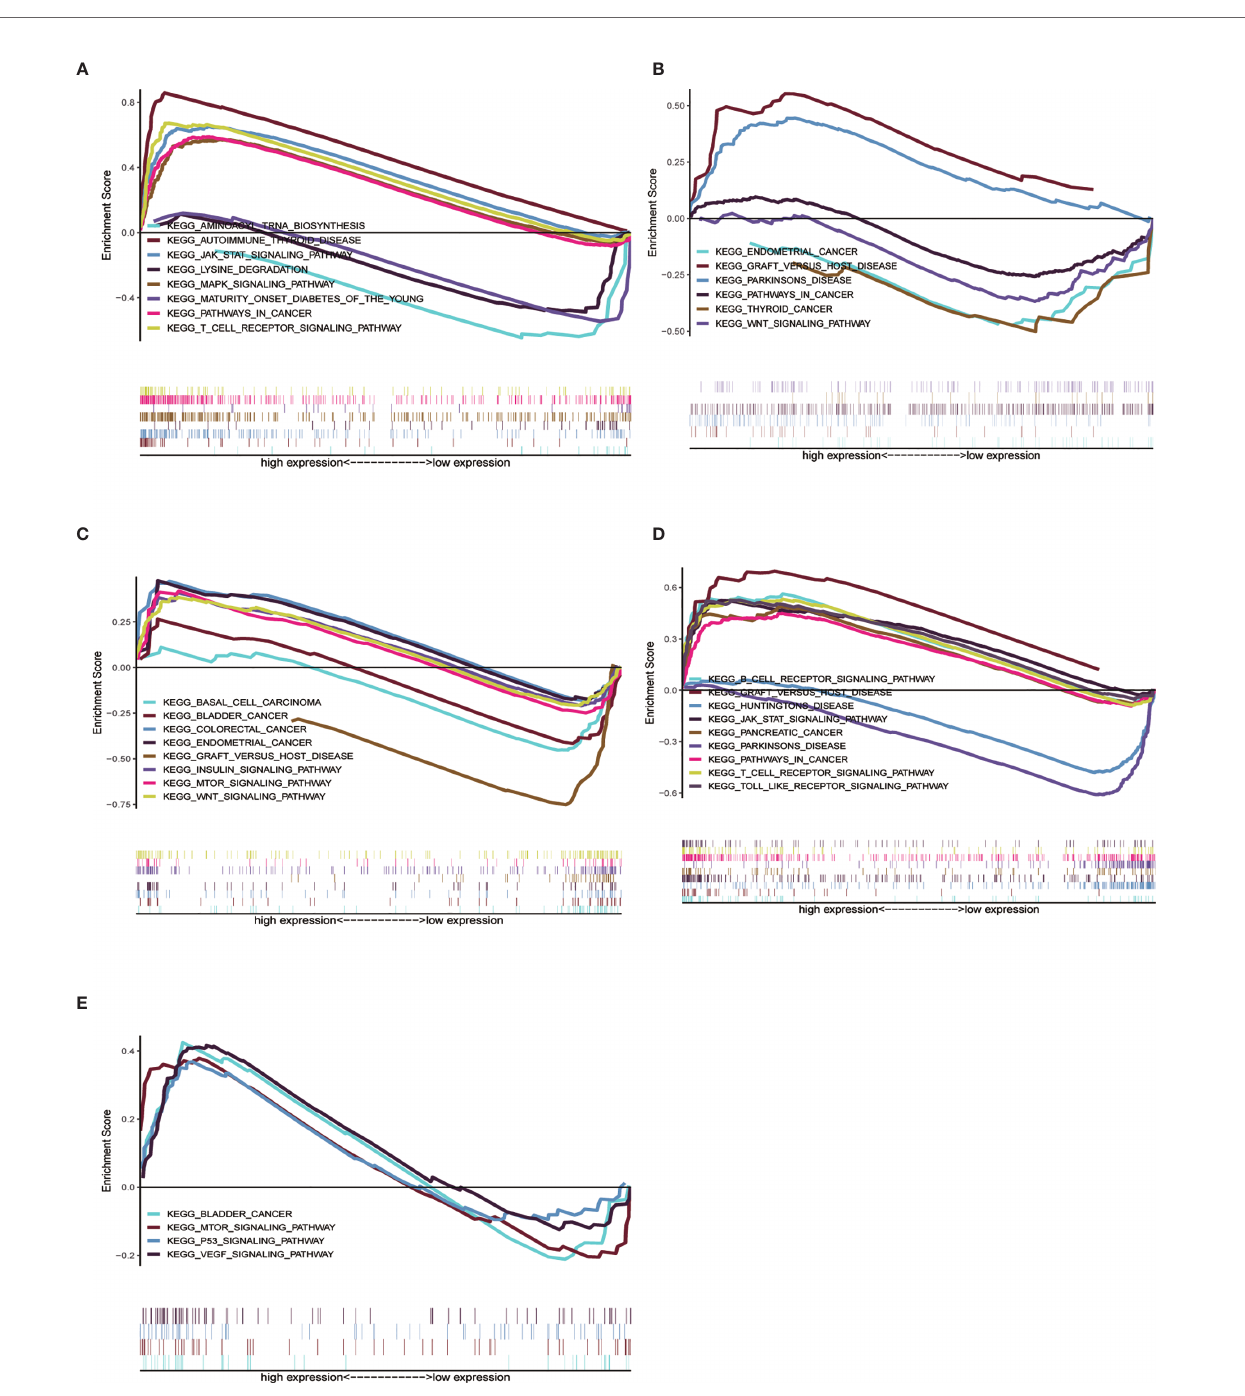
FIGURE 6 | Single gene GSEA analysis of 5 genes. (A – E) High and low expression groups of CTSL, HSPA8, MAPK9, TP63 and ULK3 genes, respectively, showed enrichment in the KEGG pathway associated with